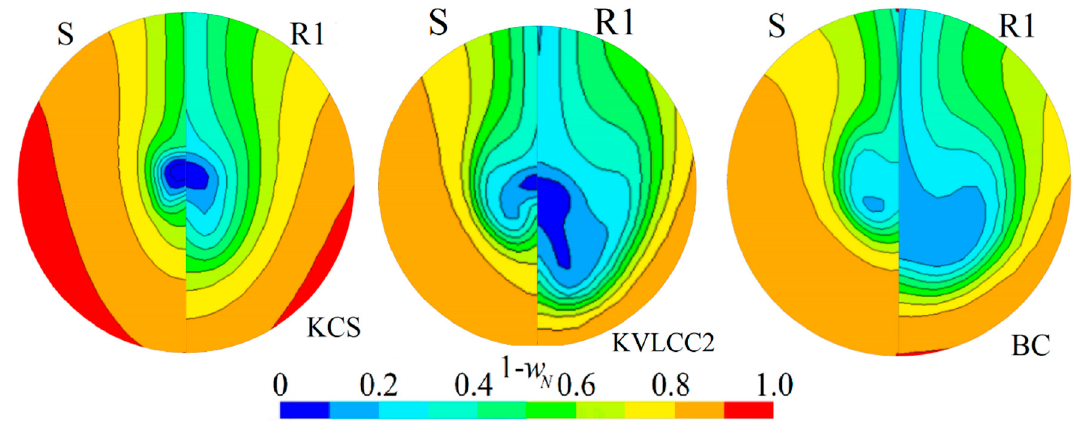
w − for smooth and fouled KCS ( left ), KVLCC2 ( middle ) and Figure 18. The obtained contours of 1 Figure 18. The obtained contours of 1 − w N for smooth and fouled KCS ( left ), KVLCC2 ( middle ) and N BC ( right ) with fouling condition R1 in the propeller disc plane. BC ( right ) with fouling condition R1 in the propeller disc plane.